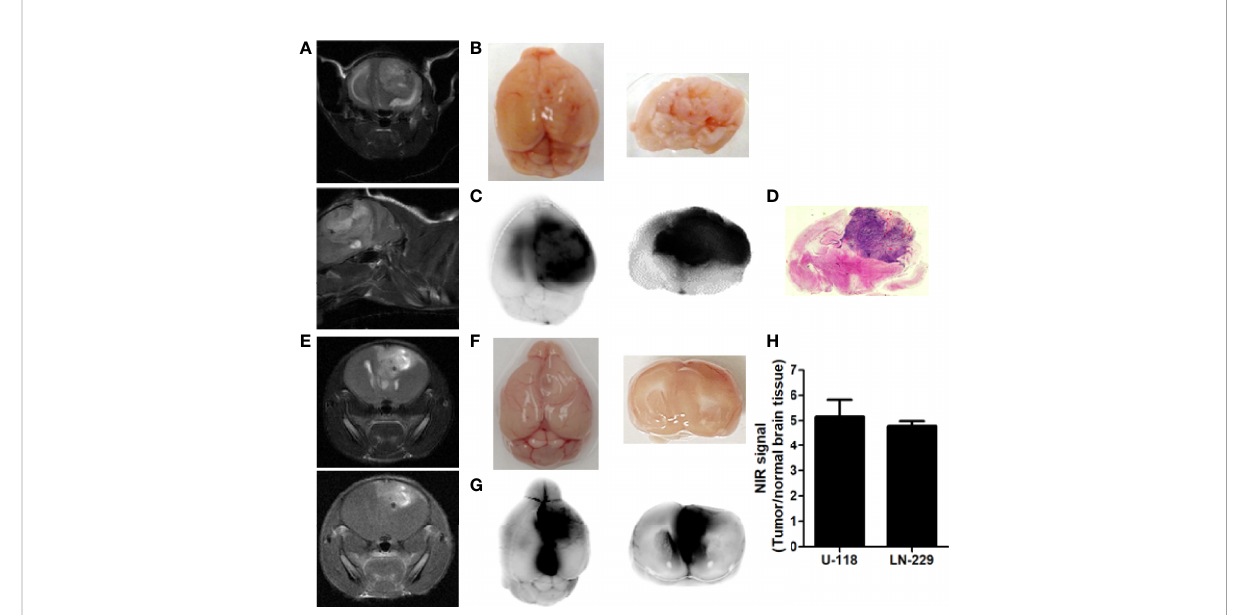
FIGURE 3 Preferential localization of p28 at tumor in the brain. MR images of the brains indicated U118 (A) , coronal (upper) and sagittal (lower) sections of T 2 -weighted images) and LN-229 tumor growth ( E : upper: coronal section of T 2 -weighted image. lower: T 1 -weighted image) in the brain. Mice bearing tumor received ICG, a near-infrared red fl uorescent dye conjugated with p28 at 0.5 mg/kg i.v. After 24h, fl uorescence images of the brain were recorded (B, F) : white light photo, (C, G) : NIR fl uorescence). Speci fi c NIR signal at 800 nm was represented as direct fl uorescence showing preferential localization of p28 at tumors. (D). The paraf fi n-embedded brain sections were stained by H, E. (H), The signal-to- background ratio (signal at 800 nm: tumor, background noise: surrounding brain tissue) was calculated. N=3 in each cell line, Mean+SD.